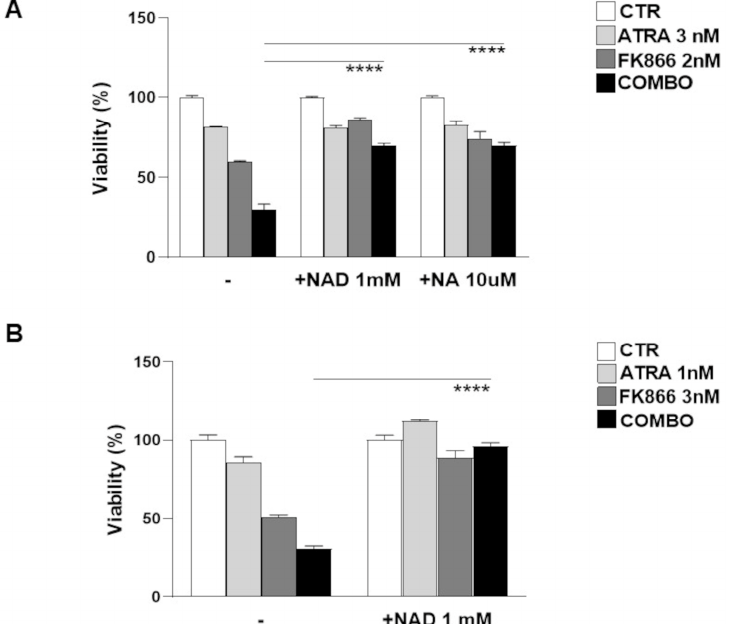
Figure 5. NAD + and Nicotinic Acid supplementation abolishes the activity of co-treatment in MM cells. Viability of LP1 ( A ) and H929 ( B ) cells treated as indicated with ATRA (1 or 3 nM), FK866 (2 or 3 nM), and their combination for 96 h in the presence or absence of NAD + (1 mM) or NA (10 µ M). Cell viability was measured with MTS assay and presented as a percentage of control. The results are a mean ± SD of triplicate samples (**** p ≤ 0.0001; unpaired t -test).